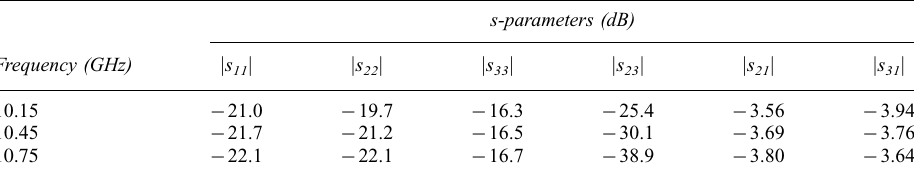
TABLE IV Exact Values of All Important s-parameters Into the Desired Frequency Range.